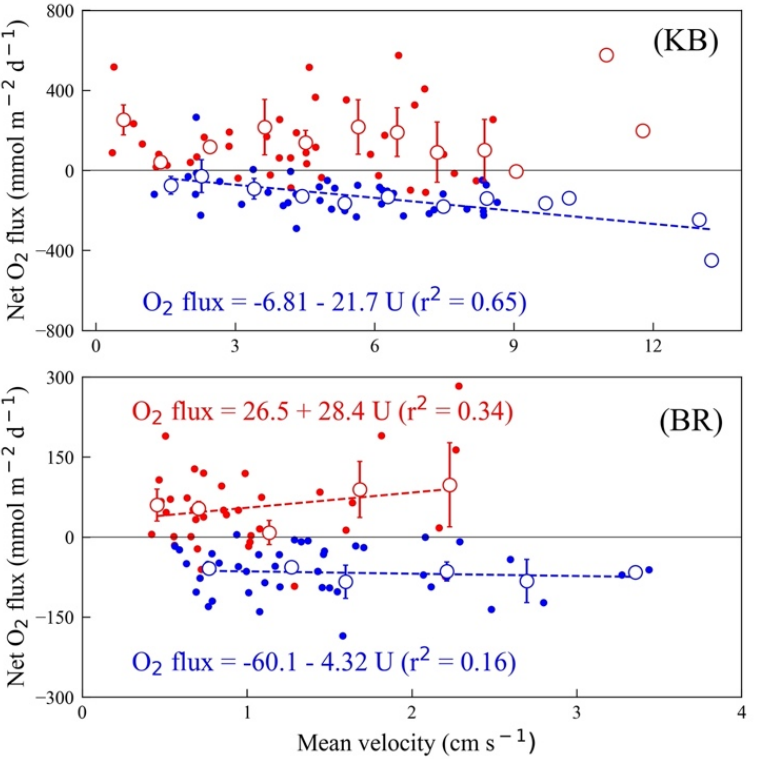
Figure 8. The relationships between net O 2 flux and mean velocity during daytime and nighttime. The solid red and blue circles represent the daytime and nighttime fluxes, respectively. The individual fluxes were assigned to 1 m s − 1 bins (open red and blue circles) to clarify the relationships. The solid red and blue lines are linear regression for daytime and nighttime, respectively. Bars represent standard errors.